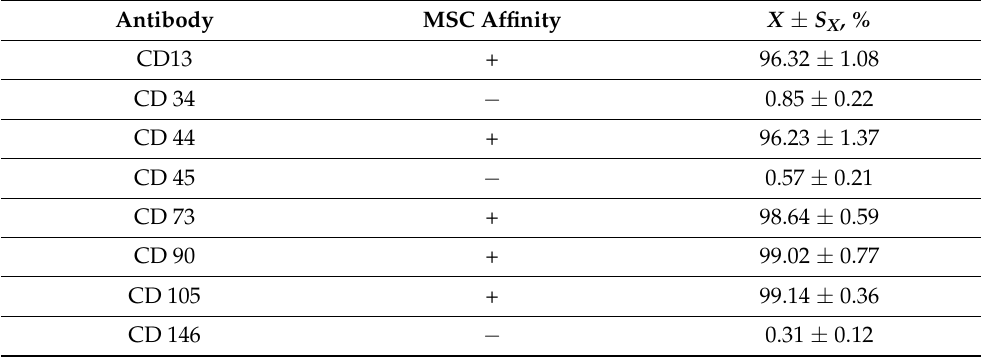
Table 2. Immunophenotyping of MSC isolated from adipose tissue ( n =